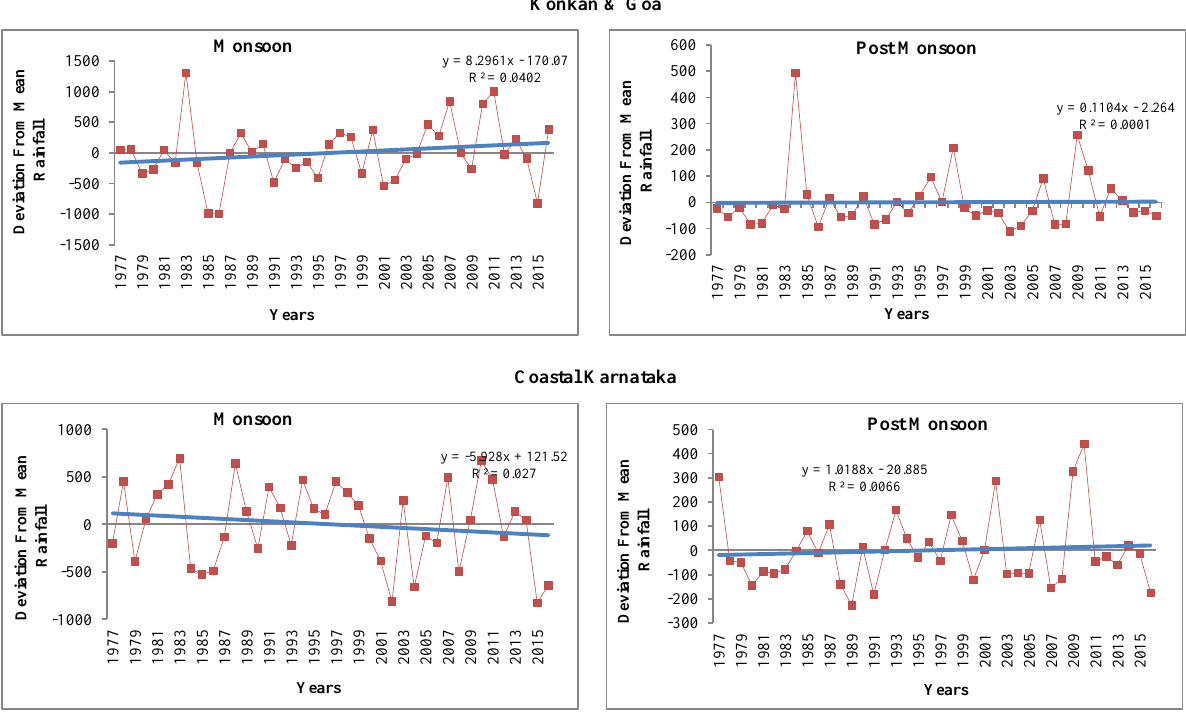
Figure 5. Monsoon & Post Monsoon rainfall trends of both meteorological